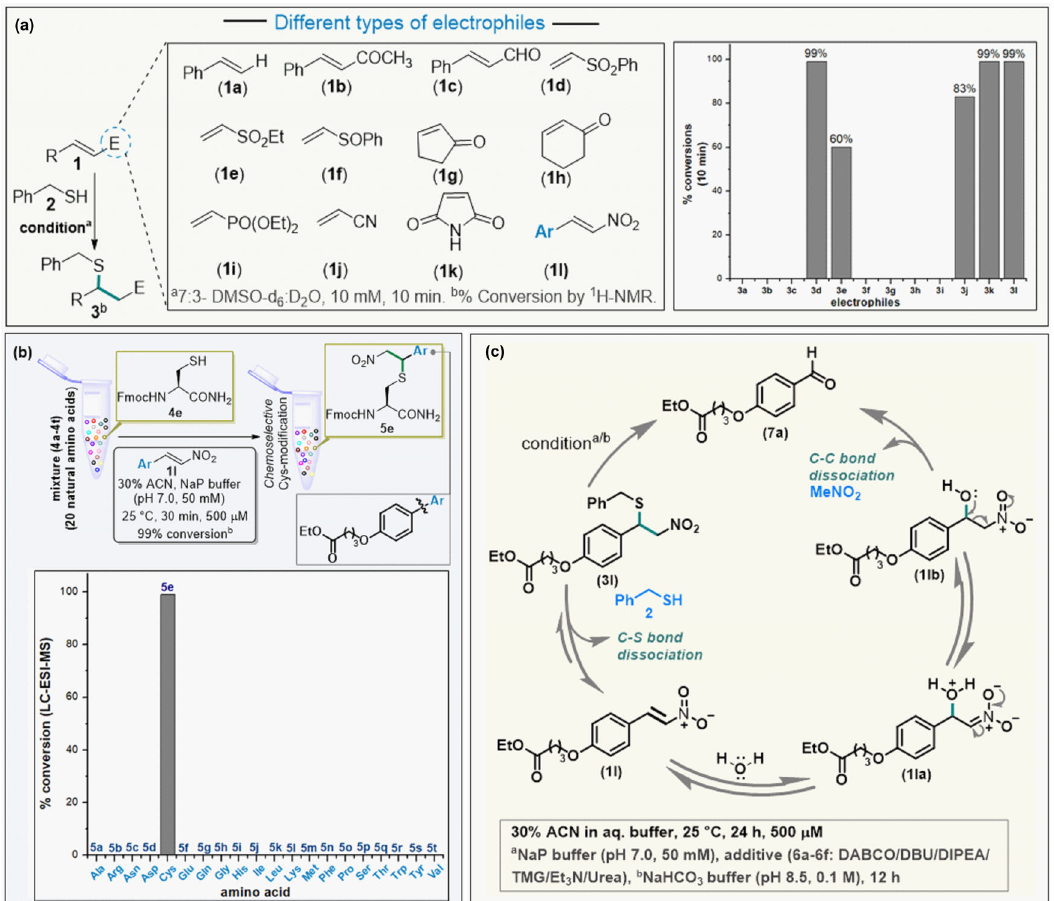
Fig. 2 | Development of Cys-based linchpin, F C . a Establishing the reactivity for C-S bond formation (Ar, -Ph-4-O(CH 2 ) 3 CO 2 Et). b Validating the chemoselectivity for C-S bond formation with Cys. c Establishing C-S/C-C bond dissociation to generate a functional group, F X , amenable for late-stage